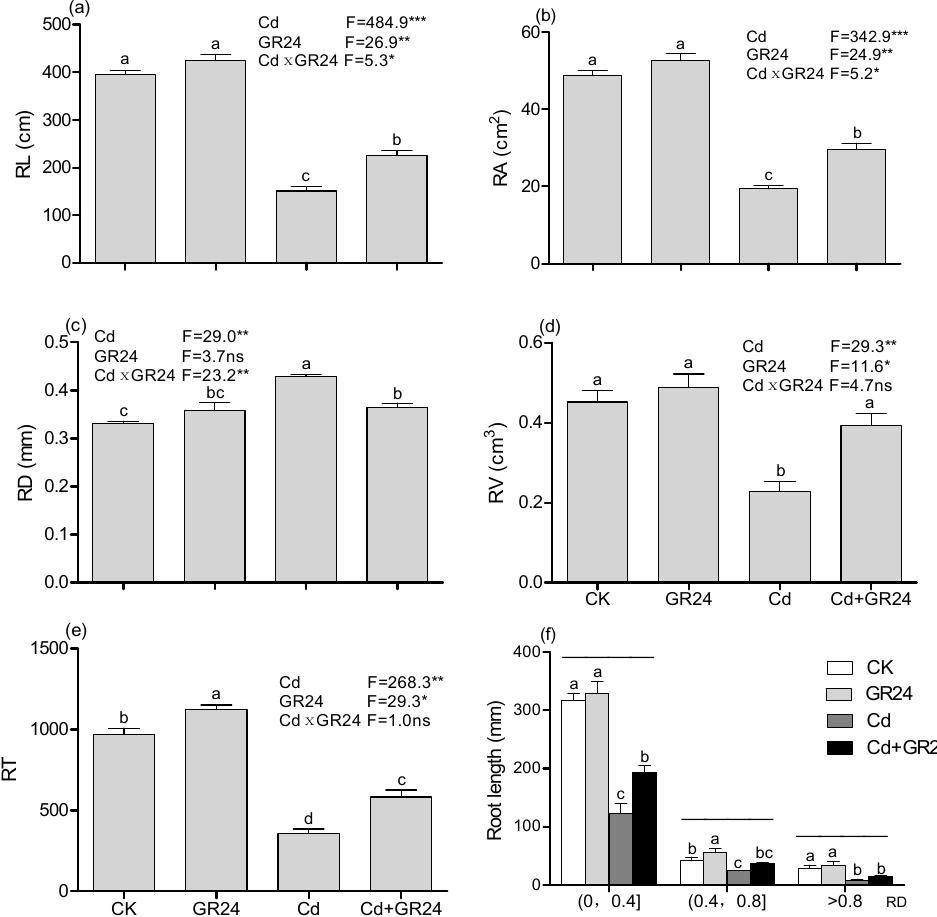
Figure 1. Root architecture parameters of seedlings exposed to different treatment. Values are means ± SD ( n = 3). ( a ) RL: root length; ( b ) RD: root average diameter; ( c ) RA: root surface area; ( d ) RV: root volume; ( e ) RT: number of root tips; ( f ) root diameter classes. Different letters above the bars were significantly different ( a–e ), significant comparison under the same horizontal line ( f ) at the 0.05 level (Duncan’s test), ns: not significant, * p < 0.05, ** p < 0.01, *** p < 0.001.